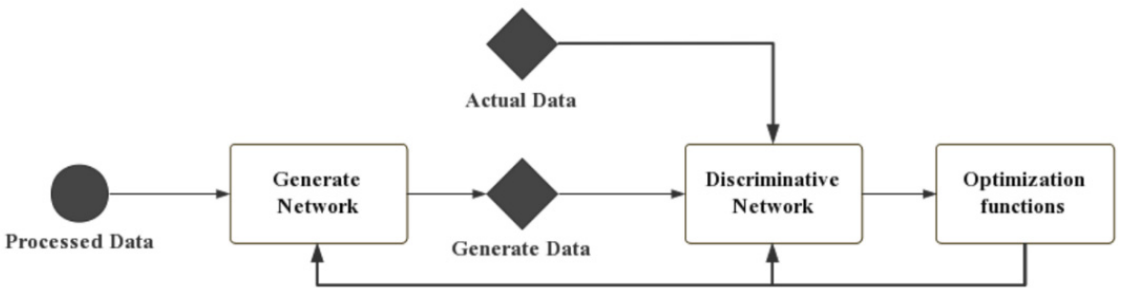
Figure 1. The general form of a GAN.